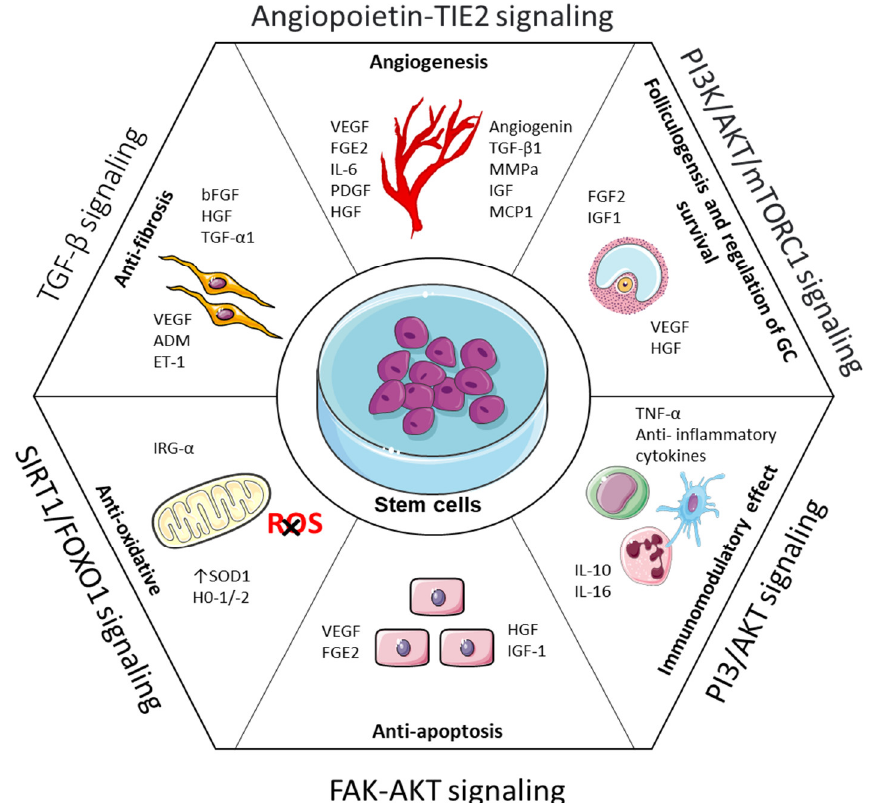
Figure 4. Mechanisms involved in stem cell-based therapies in POF.